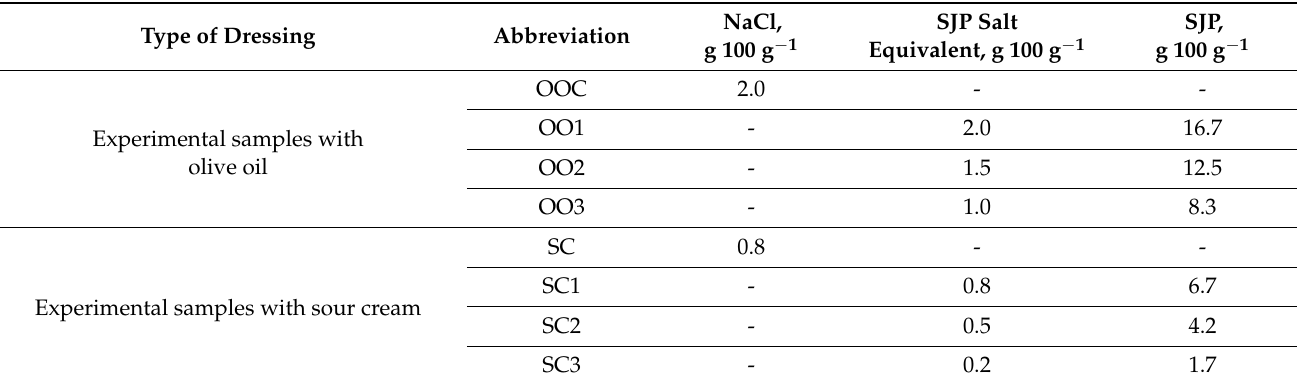
Table 1. Samples and abbreviations of NaCl, DSJ salt equivalent, and DSJ amounts used in the samples. Type of Dressing